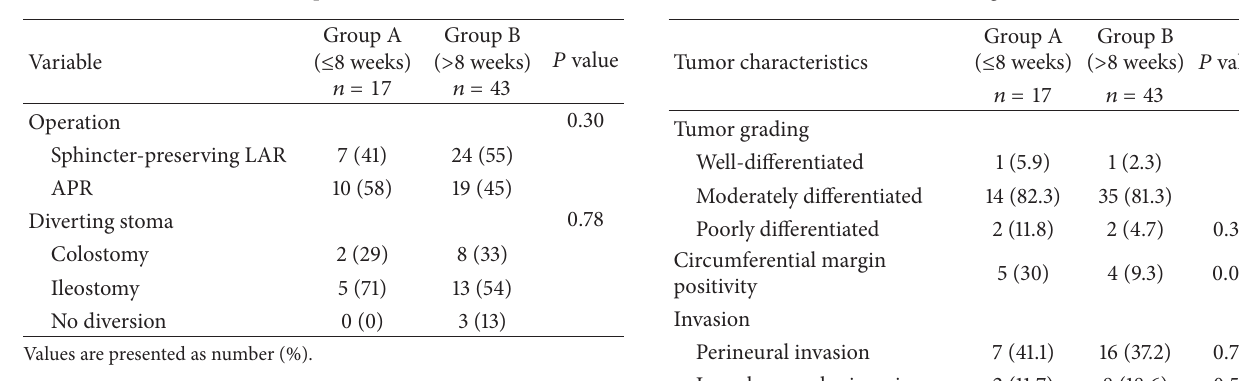
Table 2: Operative data.